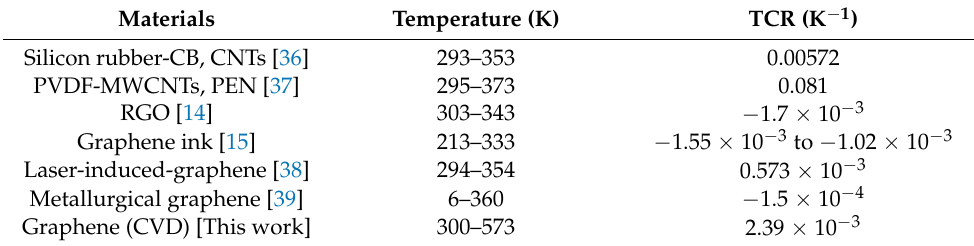
Table 1. Comparison of different materials’ temperature